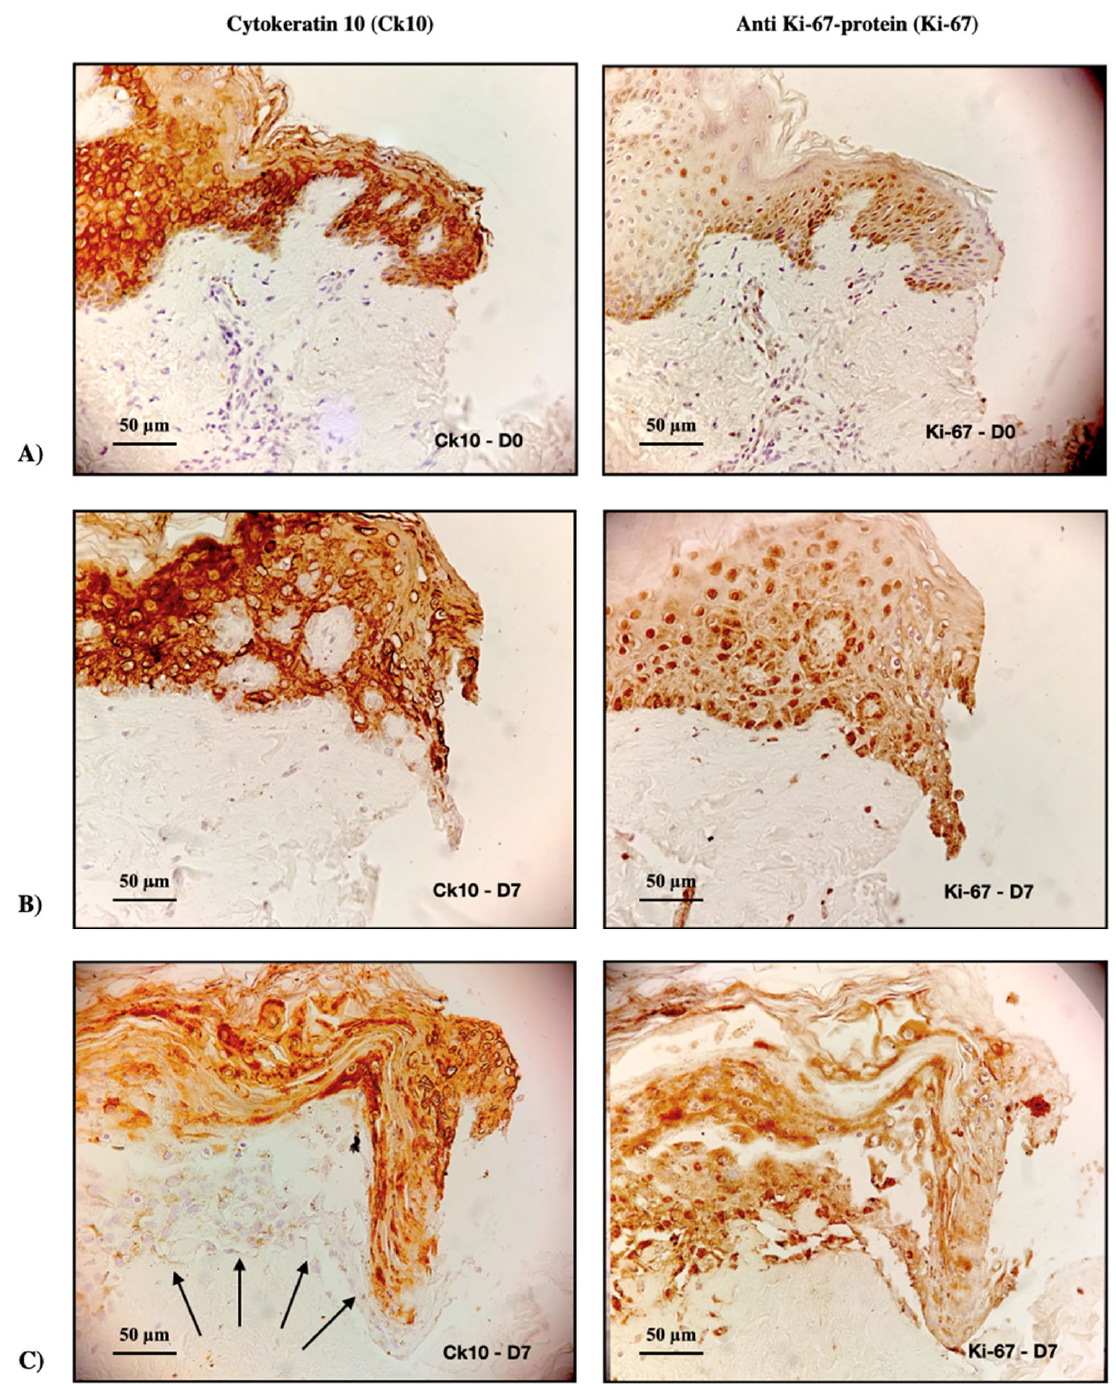
Figure 8. Immunohistochemical evaluation of the left ulcers’ edge in human skin fragments immediately after inducing the ulcer ( A ) and after 7 days (D7) treated daily with Nano-1 ( B , C ). The images on the left panel represent cytokeratin Ck10 stains (Ck10), and those on the right panel represent anti Ki-67-protein stains (Ki-67). Arrows indicate cells in the early stages of differentiation; 200 × magnification.